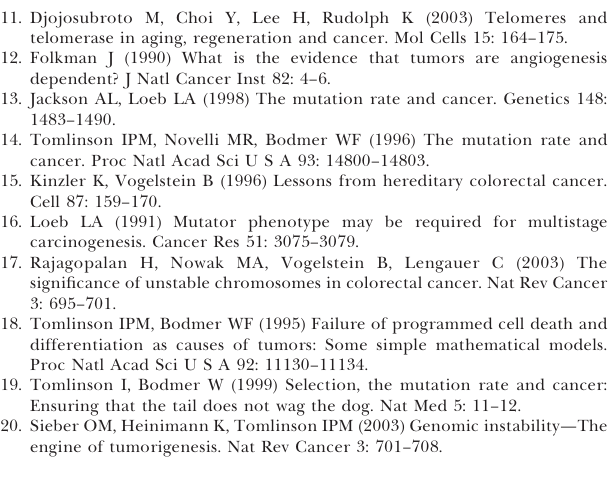
Table S1. The Number of Tumors as Categorized by the Most Common First Two Mutations Table S2. Mean, Standard Deviation, and Sample Size for Data in Figure